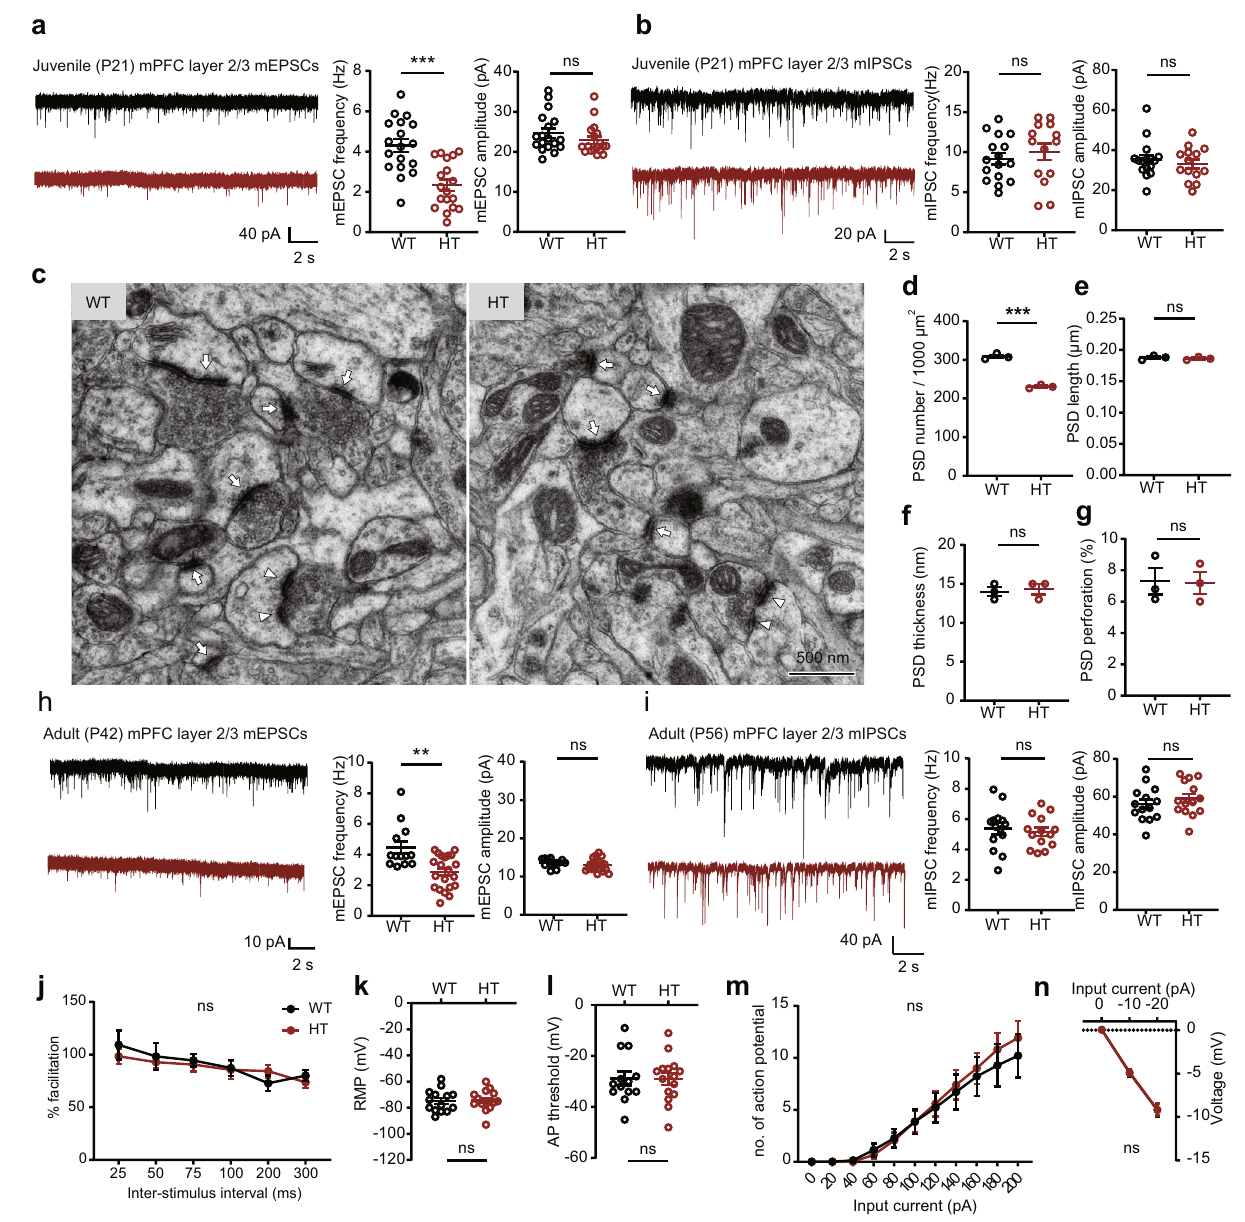
Fig. 3 | Persistently decreased excitatory synaptic density and transmission in prefrontal Arid1b +/ – neurons. a Decreased frequency, but not amplitude, of min- iatureexcitatorypostsynapticcurrents (mEPSCs) inlayer 2/3pyramidalneurons in the prelimbic region of the medial prefrontal cortex (mPFC) of juvenile (P19 – 21) Arid1b +/ – mice.( n =18neuronsfrom3mice[WT]and18,3[HT],two-tailedStudent ’